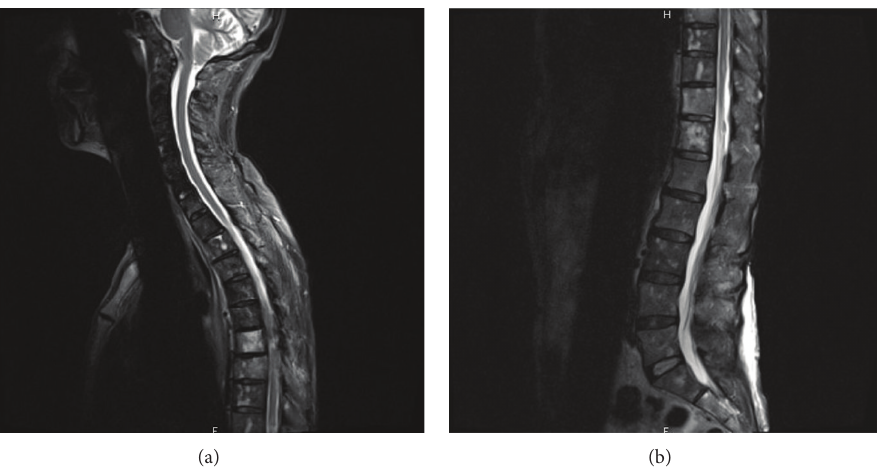
Figure 1: MRI evidence of leptomeningeal carcinomatosis before treatment with IT trastuzumab.